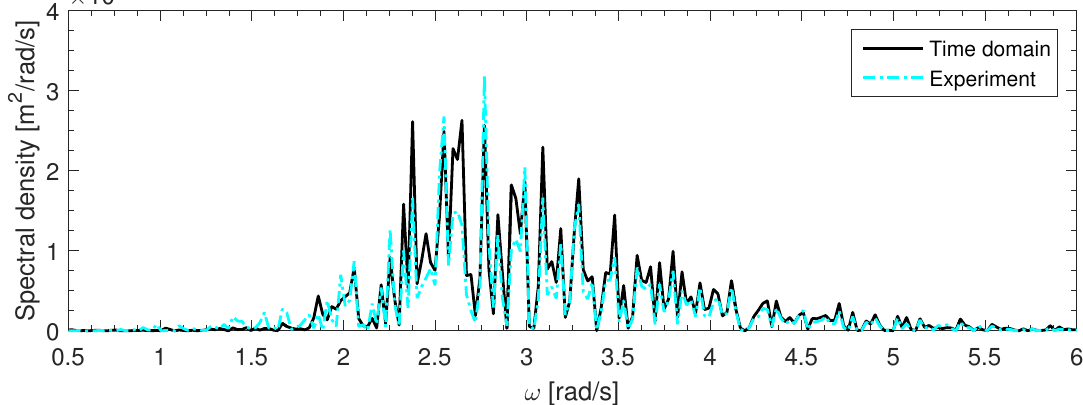
Figure 9. Spectral density of surge response (RMSE of computed and experiment results = 2.3 × 10 − 5 ). From the irregular wave response, the RAO or normalised response RN shown in Figures 10 and 11 was obtained via Equation (14):